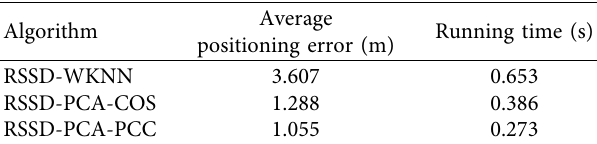
Table 5: Computational complexity comparison of diferent algorithms.